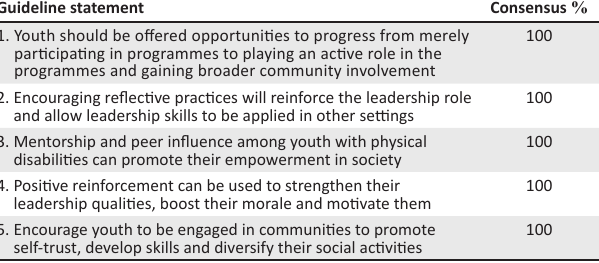
TABLE 7: Guidelines on role modelling and peer support among youth with disabilities within their communities and societies. Guideline